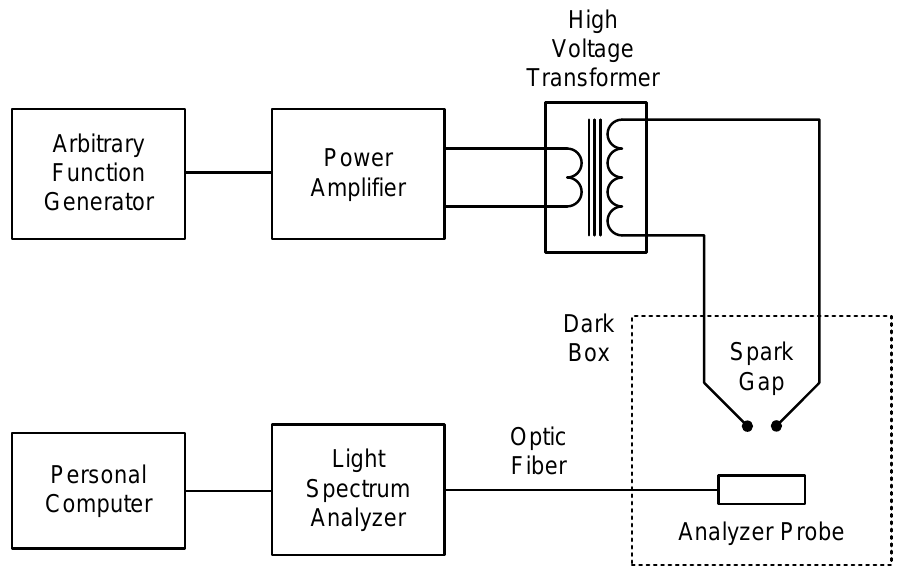
Figure 1. Diagram of the measuring system.